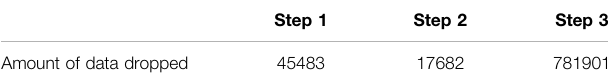
TABLE 4 | The amount of data dropped in each step.